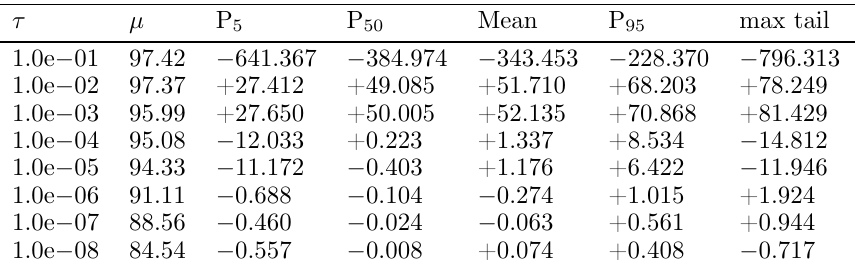
Table 7. Error on k ∞ in pcm after lossy compression by truncated HT on the MOX dataset with separate matrices M per nuclide and reaction.